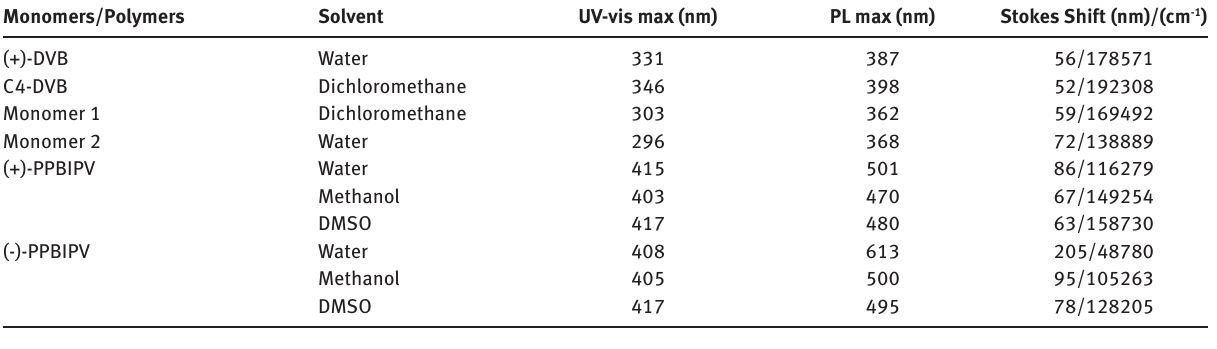
Table 1: Optical properties of (+)-DVB, C4-DVB, monomer 1, monomer 2, (+)-PPBIPV and (-)-PPBIPV. Monomers/Polymers